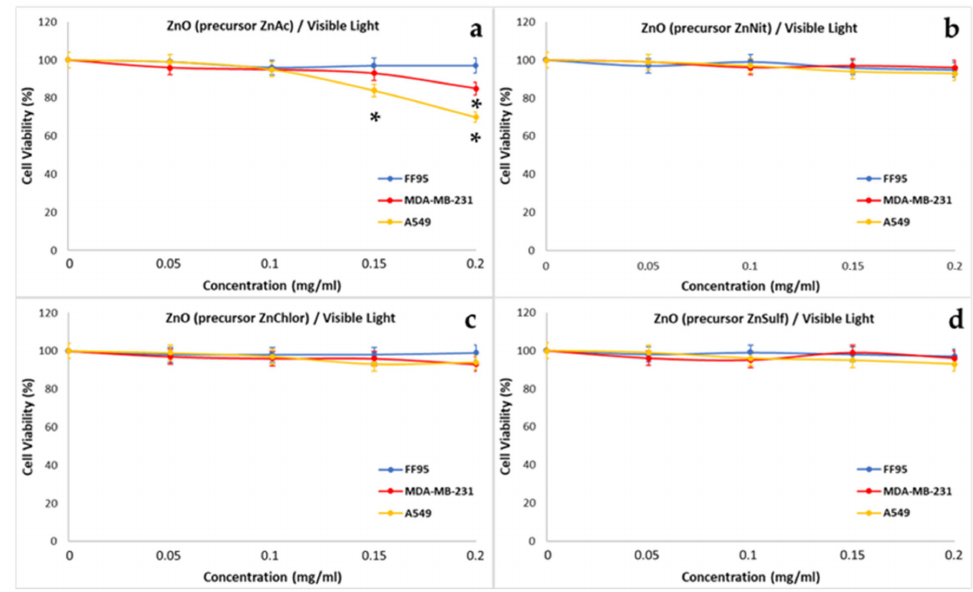
Figure 23. Effect of photo-activated with visible-light ZnO nanoparticles, synthesized using as precursor: ( a ) zinc acetate dehydrate (ZnAc), ( b ) zinc nitrate hexahydrate (ZnNit), ( c ) zinc chloride (ZnChlor), and ( d ) zinc sulphate heptahydrate (ZnSulf) on FF95, MDA-MB-231, and A549 cells. There is not any significant decrease in cell population of any of the three cell lines as a result of the addition of the photo-excitement of ZnNit, ZnChlor, and ZnSulf. Photo-activated ZnAc decreased the cell viability of A549 cells by ~30%, and 20% that of MDA-MB-23 at a concentration of 0.2 mg/mL. Furthermore, the cell viability of A549 was finally 85% after being treated with 0.15 mg/mL of ZnAc. * p < 0.05 was considered as statistically